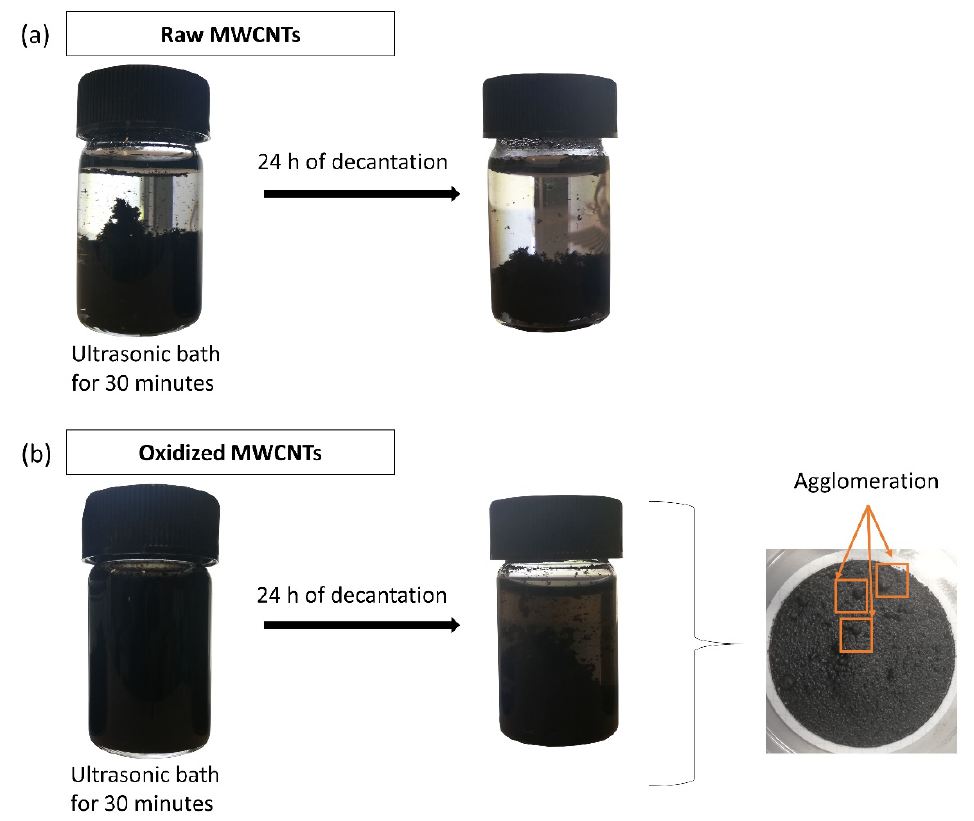
Figure 3. Dispersion experiments of ( a ) raw and ( b ) oxidized MWCNTs. Photographs were taken after 30 min of dispersion in an ultrasonic bath and after 24 h of decantation.